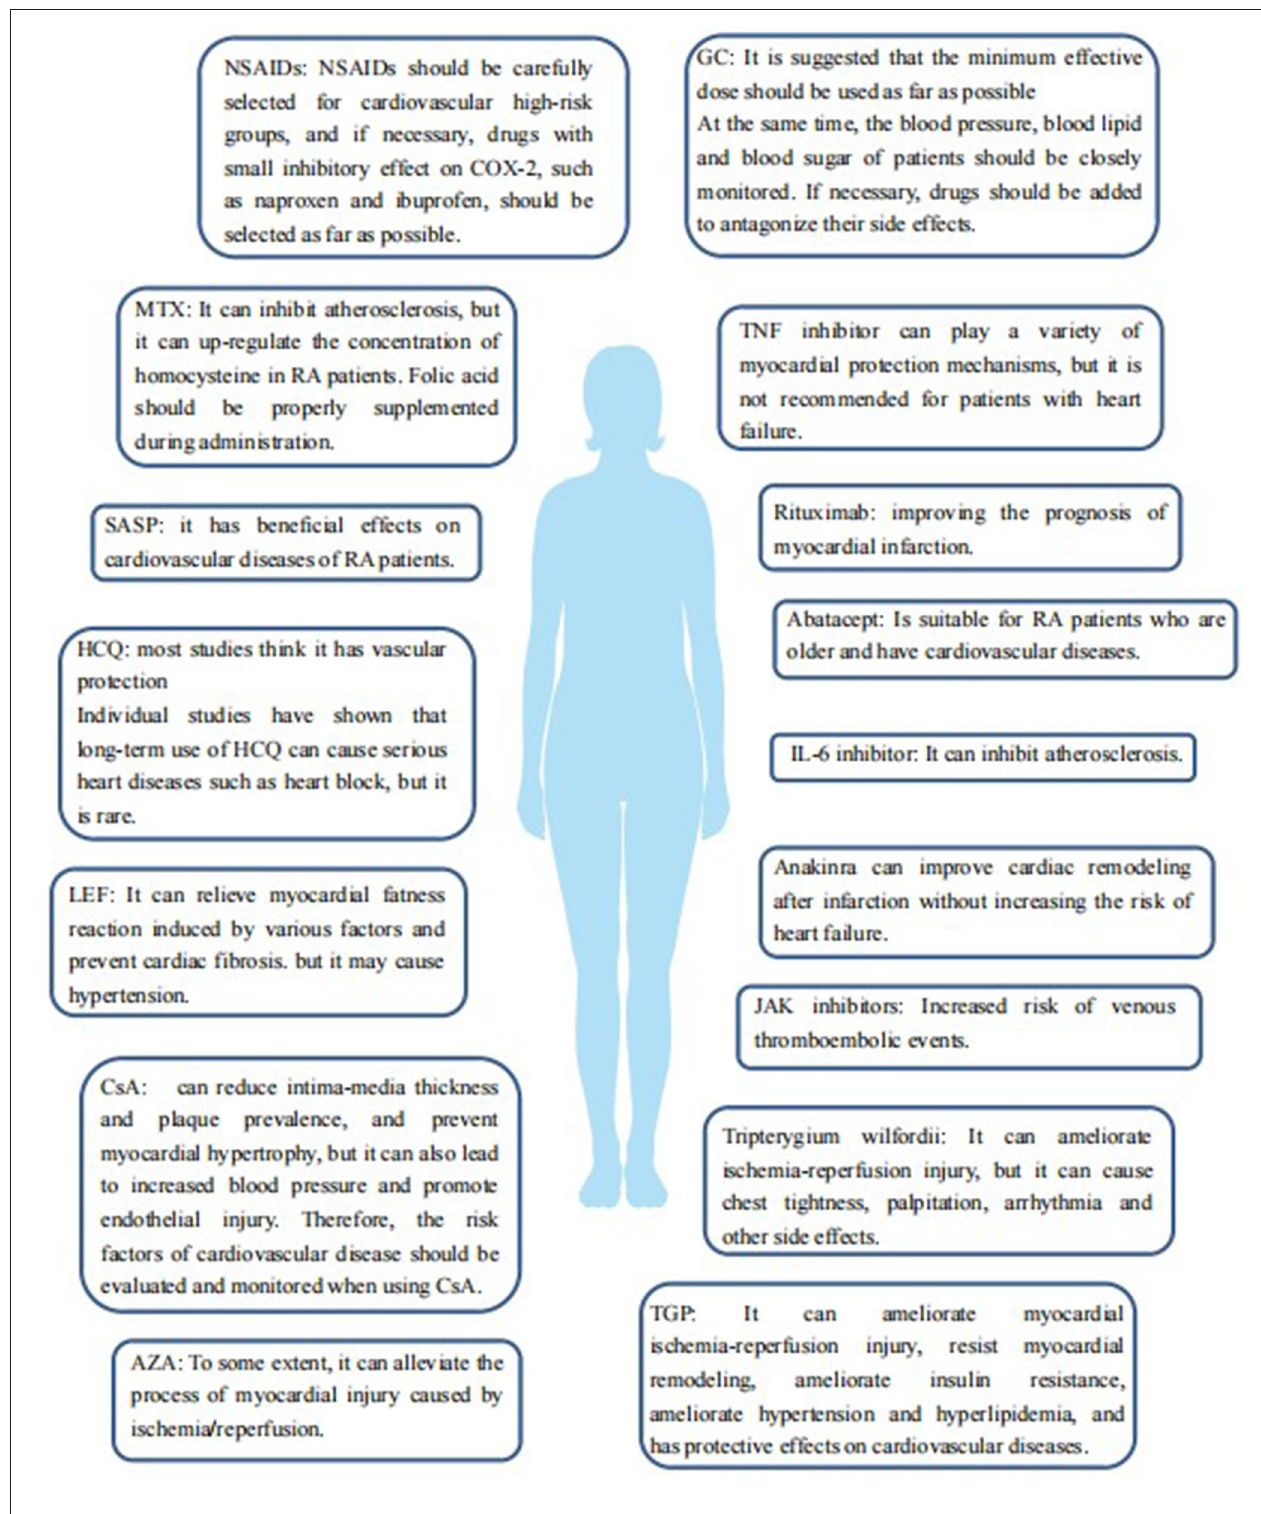
Frontiers in Cardiovascular Medicine |